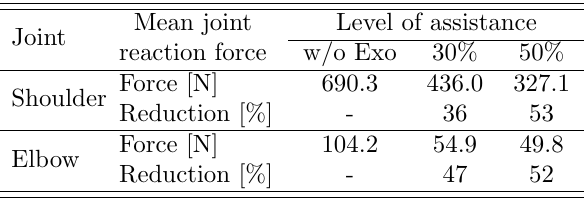
Table 6: Human energy consumption during overhead reach Energy consumption Table 7: Magnitude of the mean joint reaction forces during overhead reach